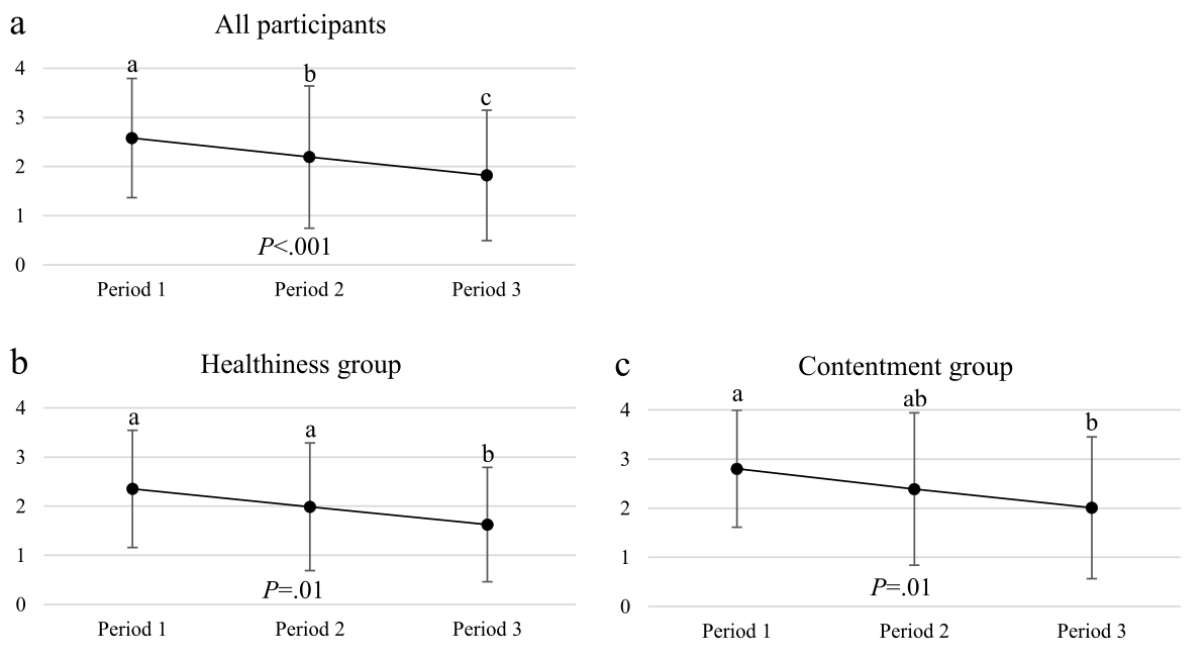
Figure 5. Adherence to usage of the Button application. The average number of times the application was opened per day during the three periods in